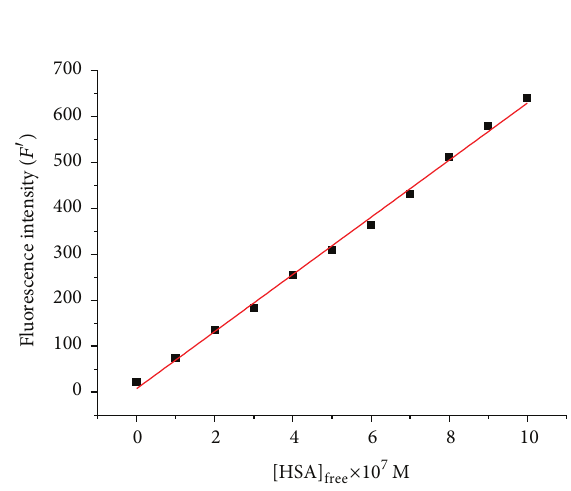
Figure 4: Linear regression analysis between [ HSA ] the Synchronous fluorescence intensity when Δ𝜆 = 60 nm), 𝐶 ( = 0, 1, 2, 3, 4, 5, 6, 7, 8, 9, 10 × 10 −7